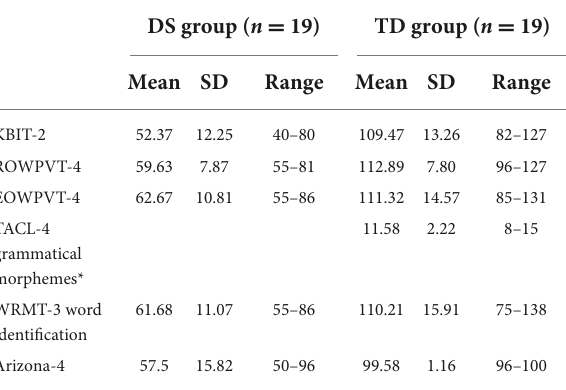
TABLE 3 Participant characteristics in standard score or scaled score means, standard deviations, and